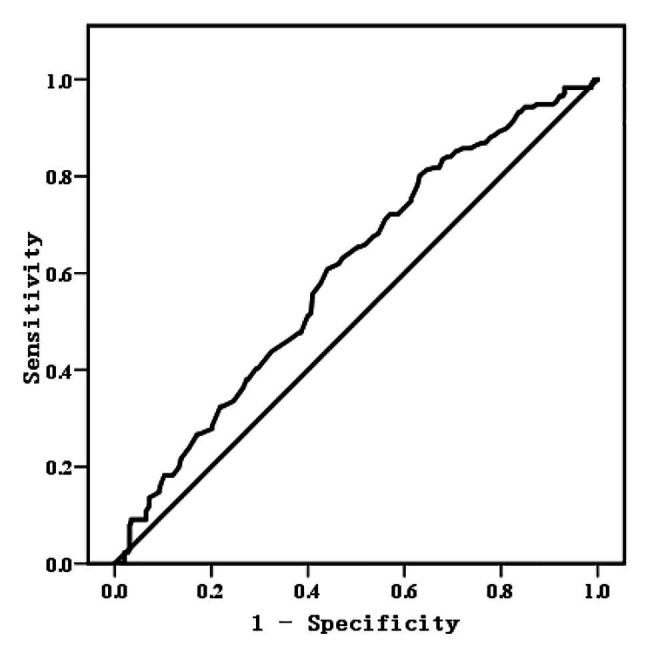
Receiver operator characteristic (ROC) curve for evaluating the Decision Tree model (DT model).